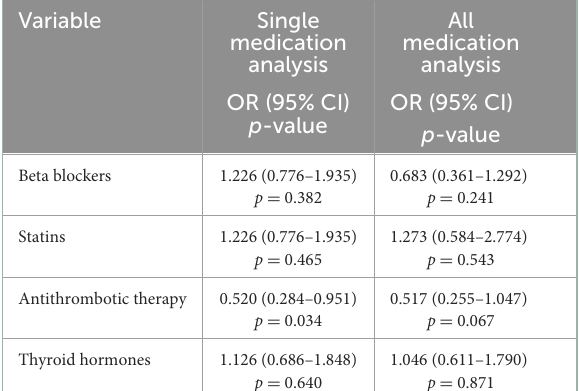
TABLE 2 Logistic regression analysis of medication intake and ICH as a mode of presentation (age and sex